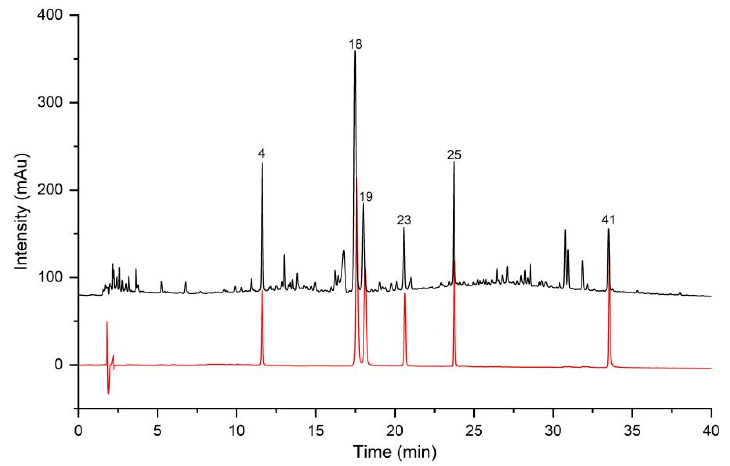
Figure 5. Typical UHPLC chromatograms of cLJF (the black line) and mixed standard solutions (the red line). P4, neochlorogenic acid; P18, chlorogenic acid; P19, cryptochlorogenic acid; P23, sweroside; P25, secoxyloganin; P41, 4,5 ‐ Di ‐ O ‐ caffeoylquinic acid.